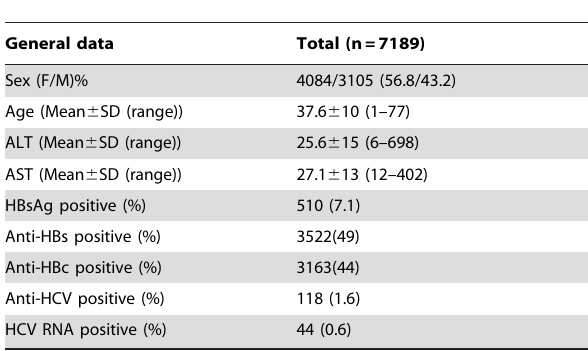
Table 1. General features of 7189 people in Wuwei.